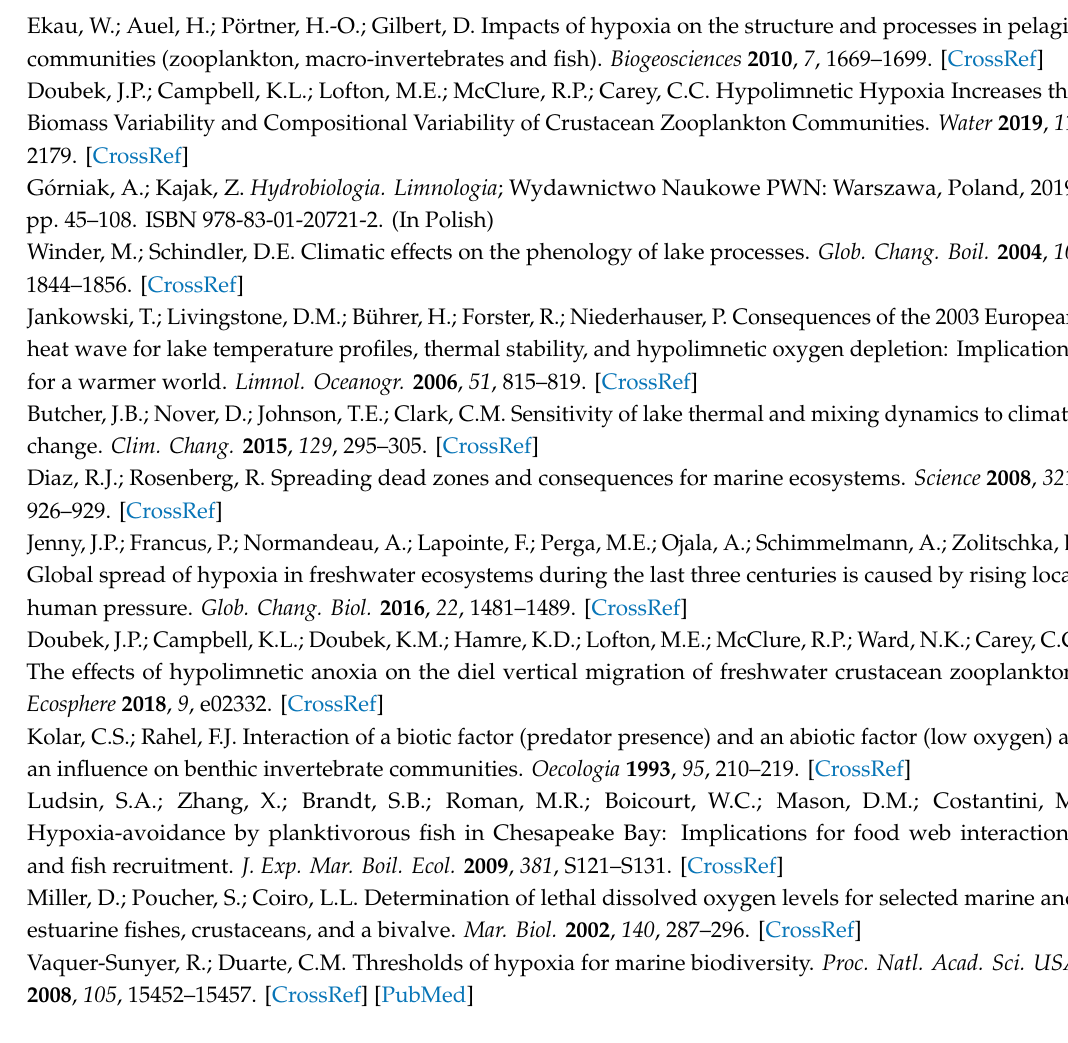
Table S1. Frequency (%) of zooplankton taxa occurrence in harmonic and dystrophic lakes with di ff erent oxygen conditions